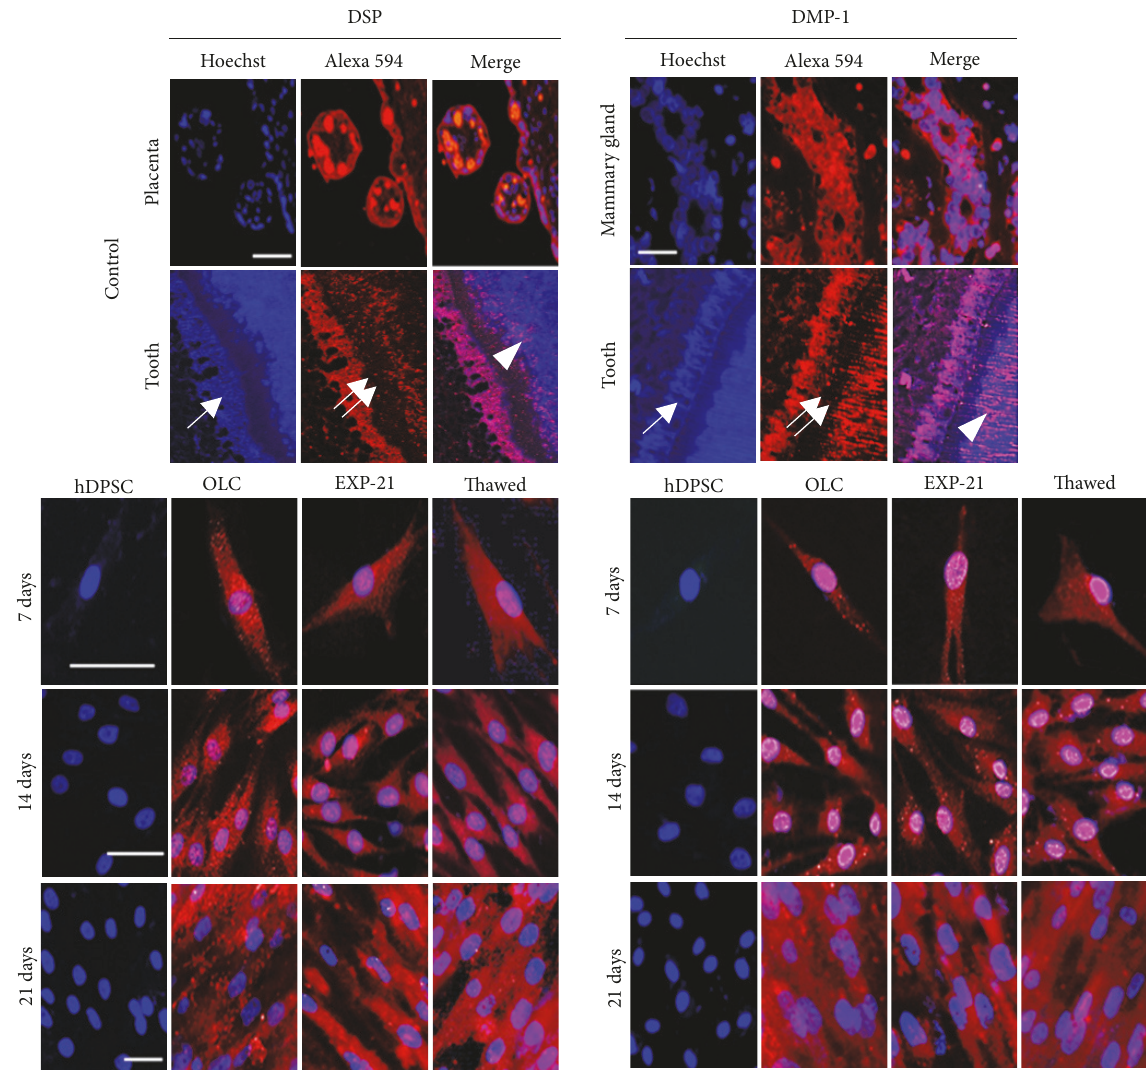
Figure 3: Immunofluorescence analysis of DSP and DMP-1 localization . Staining of respective positive controls for DSP (placenta) and DMP-1 (mammarygland).Inthetooth,alayerofcolumnarodontoblasts(arrow)surroundstheinnersurfaceofdentinandshowspositivestainingfor both DSP and DMP-1; negative staining in the predentin area was observed (double arrow) and positive staining on the dentin mineralization front (arrowhead). To obtain a detailed protein marker location in cell cultures, they were processed for Alexa 594 immunofluorescence with antibodies to DSP or DMP-1 and Hoechst to stain nuclei after 7, 14, and 21 days of differentiation period (OLC) and 7, 14, and 21 days after reseeding process in fresh cells (EXP-21) and thawed EXP-21 cells (Thawed). Note the intense nuclear staining of DMP-1 and the absence of staining in mesenchymal cells. Bar corresponds to 100 𝜇